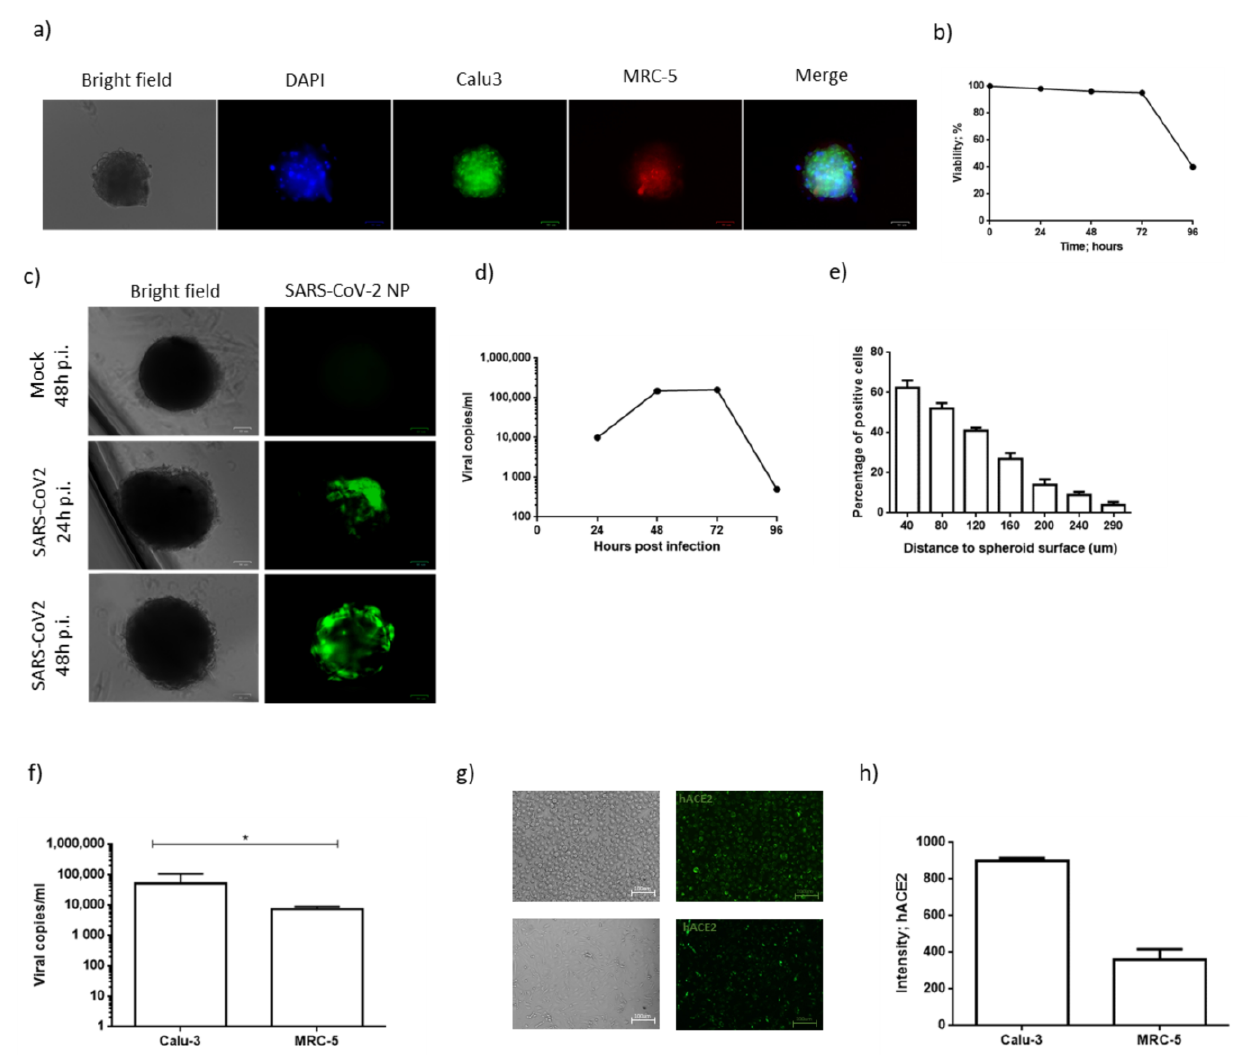
Figure 1. ( a ) A representative Calu-3/MRC-5 multicellular spheroid, 48 h after culture. Calu-3 and MRC-5 single-cell suspensions were pre-stained with Syto9 and Syto59, respectively. DAPI was used for nuclear staining. Scale bar 100µm. ( b ) Graphic representation of the percentage of viable cells during a time lapse of 96 h. Cell viability was measured by MTT assay. ( c ) Representative Calu-3/MRC-5 multicellular spheroids stained with anti-SARS-CoV-2 nucleoprotein. UV-inactivated SARS-CoV-2 (mock) was used as negative control. Scale bar 100µm. ( d ) Calu-3/MRC-5 multicellular spheroids were infected with SARS‐CoV‐2 at a multiplicity of infection (MOI) of 1.0 for 1 h at 37 °C. Thereafter, the cells were washed and cultured for 24, 48, 72 or 96 h. Viral yield was quantified in the cell supernatant using quantitative reverse‐transcription PCR (RT‐qPCR). At least three independent replicates were tested. Data represent three independent experiments. ( e ) Percentage of NP-positive cells, subdivided according to the distance to spheroid surface. Data are expressed as mean +/− standard deviation. ( f ) Calu-3 or MRC-5 cells were SARS‐CoV‐2 at a multiplicity of infection (MOI) of 1.0. Viral yield was quantified in the cell supernatant using quantitative reverse‐transcription PCR (RT‐qPCR). At least three independent replicates were tested. Data are representative of three independent experiments. ( g ) hACE2 staining of Calu-3 (upper panel) and MRC-5 (lower panel) cells. Scale bar 100µm. ( h ) Levels of hACE2 staining in Calu-3 and MRC-5 cells. Data correspond to the mean +/− standard deviation. * p value < 0.05, calculated with Student’s t test.